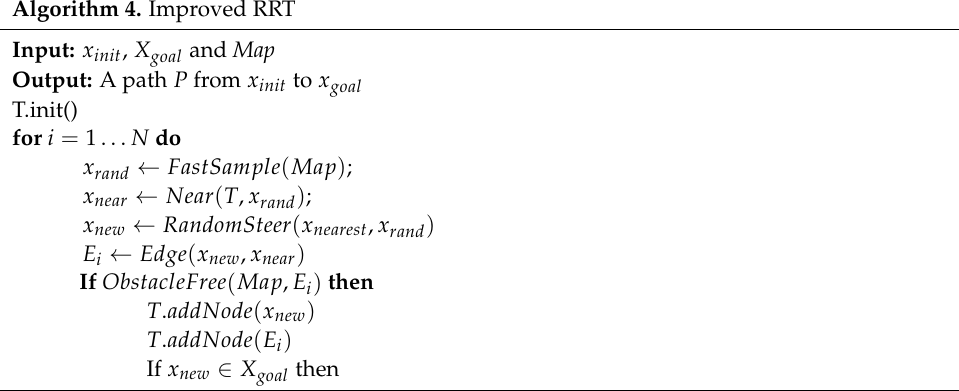
Algorithm 4. Improved